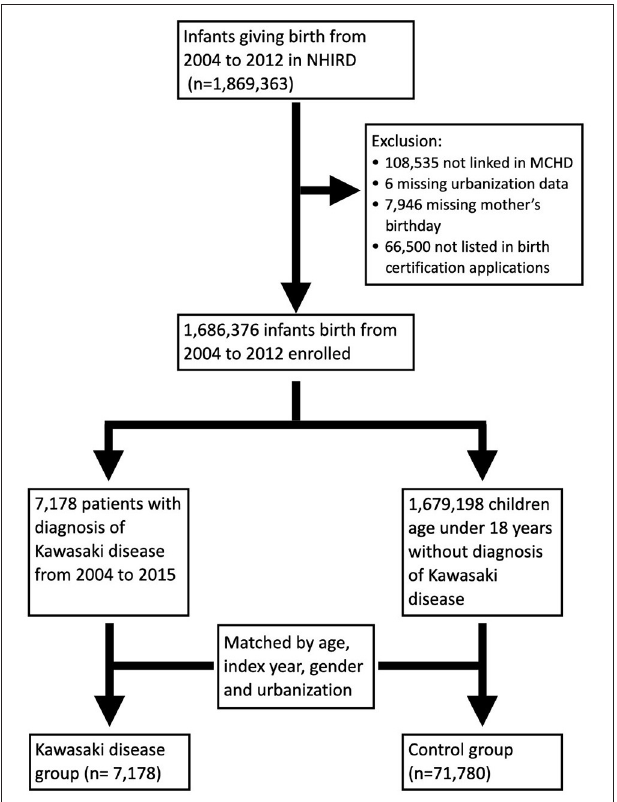
FIGURE 1 | Study population and study design.